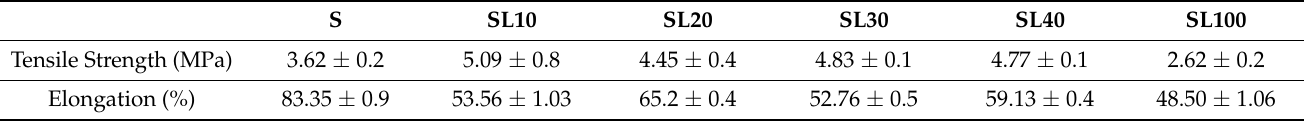
Table 1. Tensile strength and elongation of neat starch and starch-lignin composites with different number of grinding cycles. S SL10 SL20 SL30 SL40 SL100 Tensile Strength (MPa) 3.62 ±